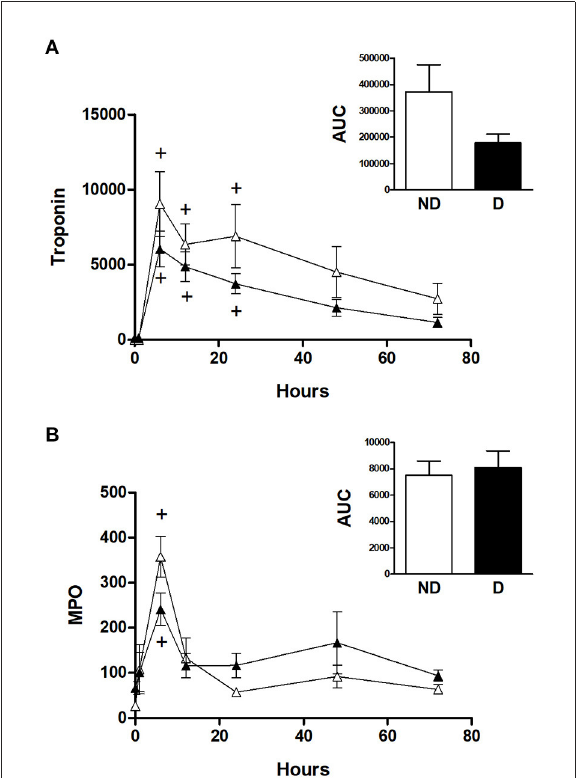
FIGURE3 Cardiac injury and systemic oxidative stress in CABG and AVR patients. Pre- and post-operative levels of (A) troponin I (ng/L) and (B) MPO (ng/ml) in patients undergoing CABG (white) or AVR (black) surgery. Values are mean ± SEM for CABG or AVR. Two-way mixed model ANOVA for (A) revealed a significant interaction between time and operation type but no significance differences from post-hoc testing and for (B) revealed no significant differences. One-way ANOVAs with post-hoc Dunnett’s test where appropriate were also performed individually for each surgery type; + represents a significant difference compared to basal levels within the same group. No statistical significance was found for the AUC (area under the curve) analyses (unpaired two-tailed student’s t -test or Mann-Whitney U -test as appropriate).